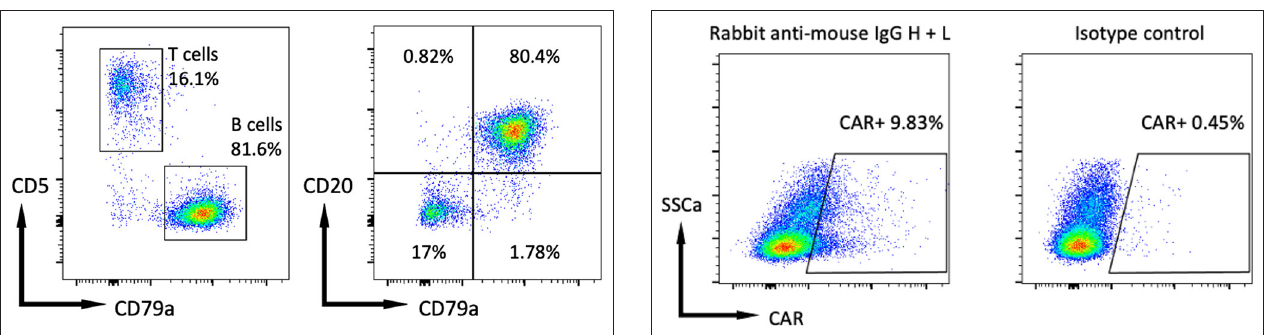
FIGURE 2 | Flow cytometry of CAR-T cell product 12 days after T cell activation. Gated on live, CD5 + cells that were stained for CAR using a biotinylated rabbit anti-mouse IgG H + L antibody and isotype control antibody with a secondary APC-streptavidin conjugate as previously described